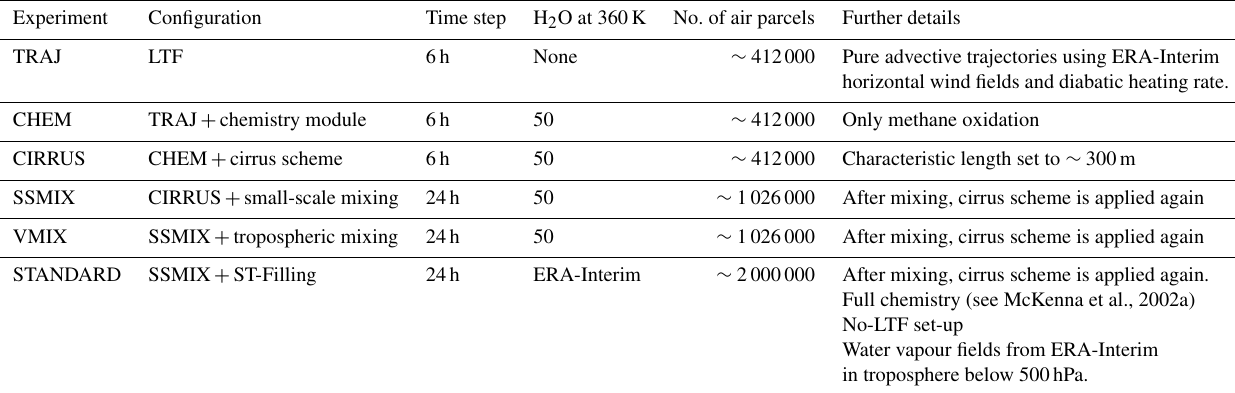
Table 1. Description of experiments done with CLaMS.